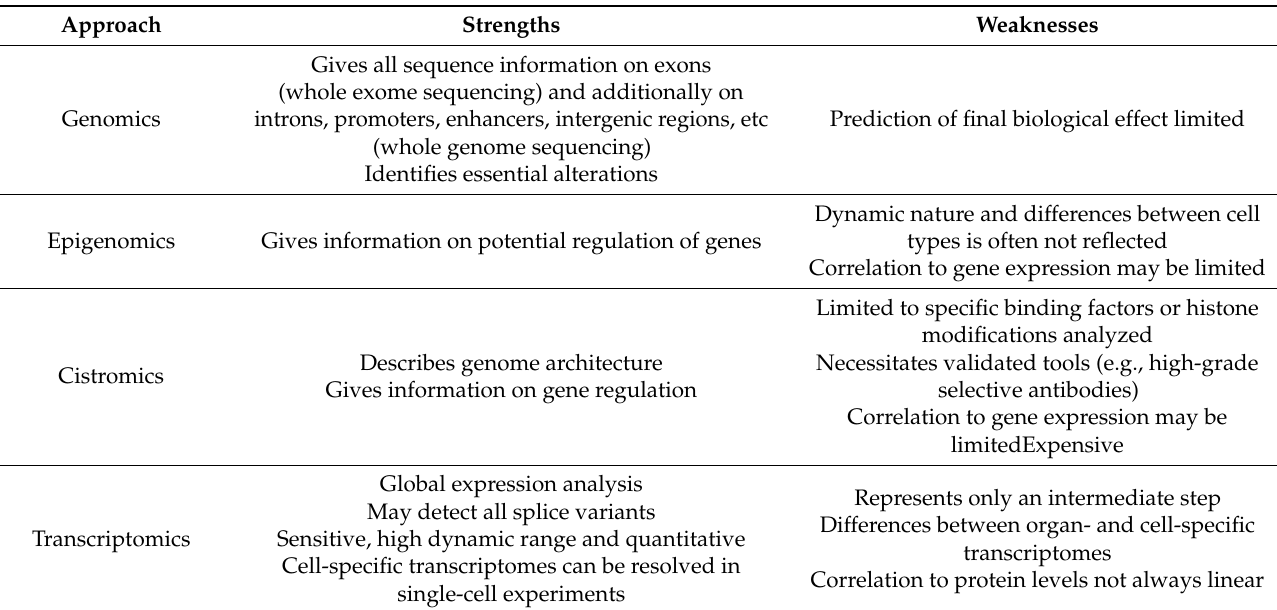
Table 1. Strengths and weaknesses of omics